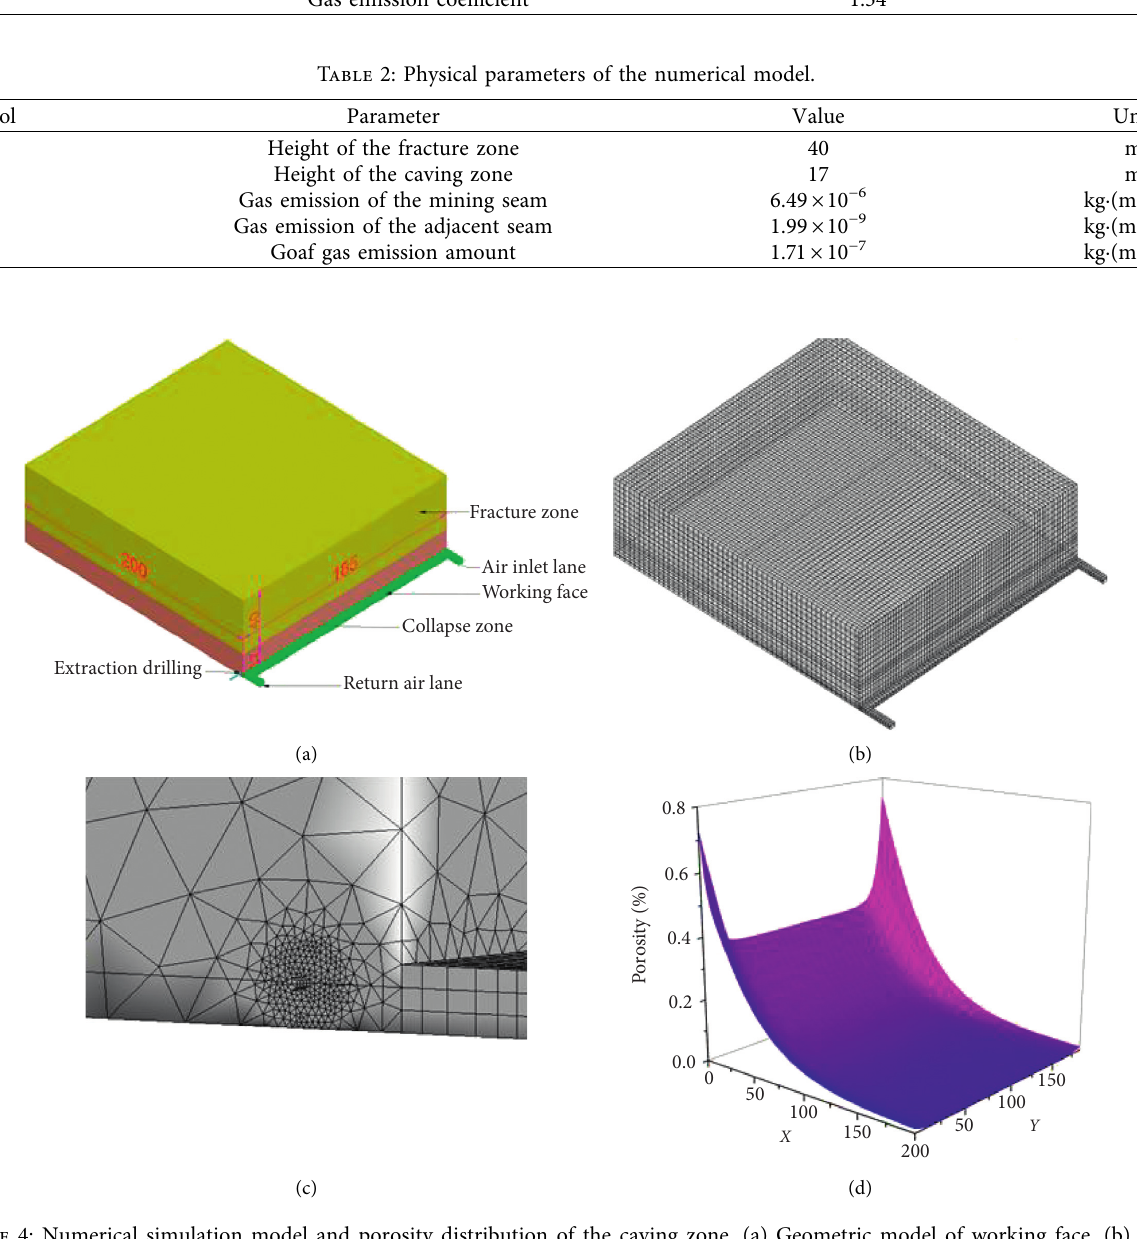
Figure 4: Numerical simulation model and porosity distribution of the caving zone. (a) Geometric model of working face. (b) Mesh generation of working face. (c) Distribution law of porosity in goaf. (d) Mesh generation of large-diameter